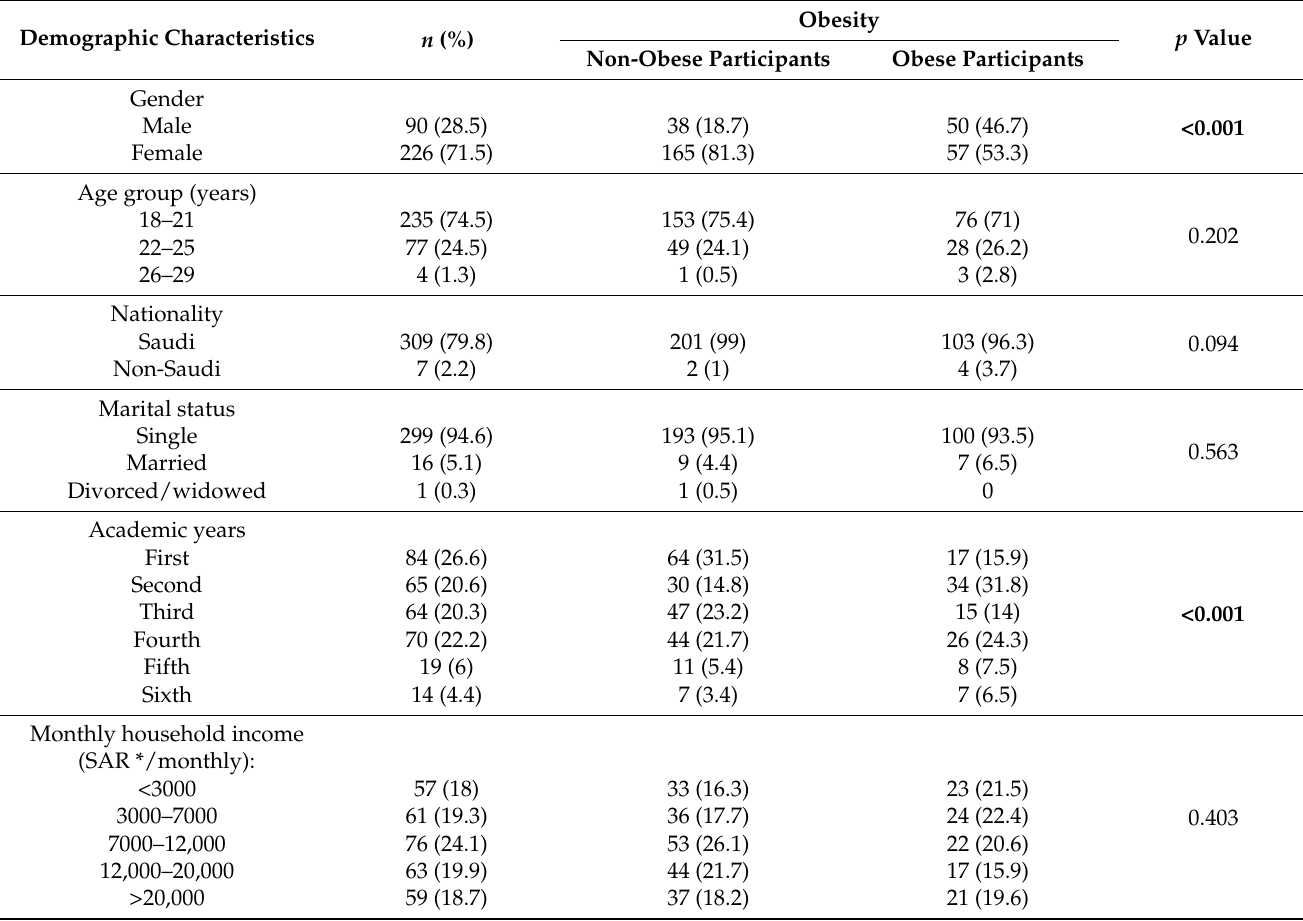
Table 1. Demographic characteristics of the study participants according to their obesity status.